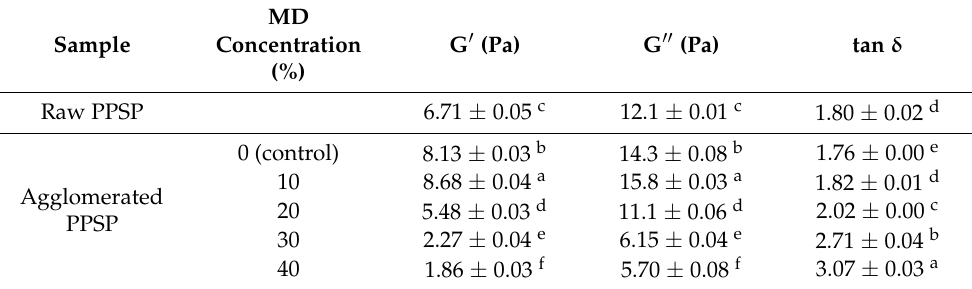
Figure 6. Plots of log G (cid:48) and log G (cid:48)(cid:48) versus log ω for raw and agglomerated PPSPs with different concentrations of MD binder: ( ) raw PPSP, ( (cid:3) ) PPSP—0%, ( (cid:52) ) PPSP—10%, ( (cid:35) PPSP—30%, and (+) PPSP—40%. Table 5. Values of dynamic rheological parameters (G (cid:48) , G (cid:48)(cid:48) , and tan δ ) of raw and agglomerated PPSPs with different concentrations of MD